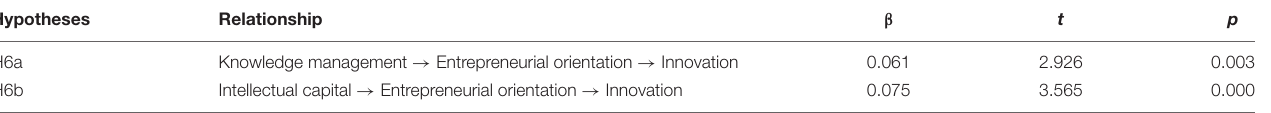
TABLE 6 | Specific indirect effect.